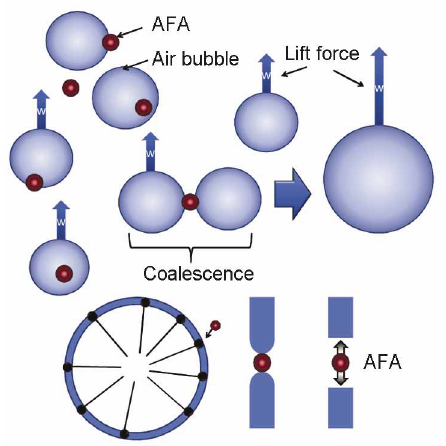
Fig. 5. Stages of the mechanism of action of an anti-foaming admixture (Łaźniewska-Piekarczyk